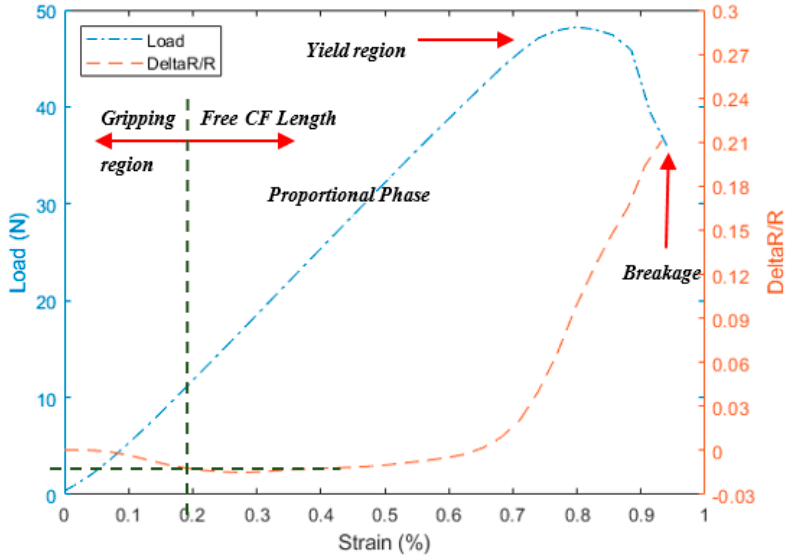
Figure 5. The tensile test for 1 K and the corresponding resistance variation measurements for configuration B.